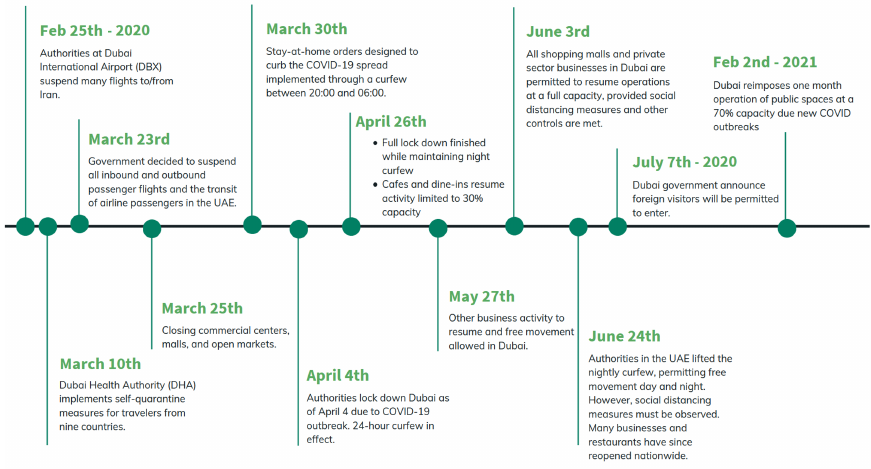
Figure 2. Timeline for COVID-19 containment actions in Dubai in 2020